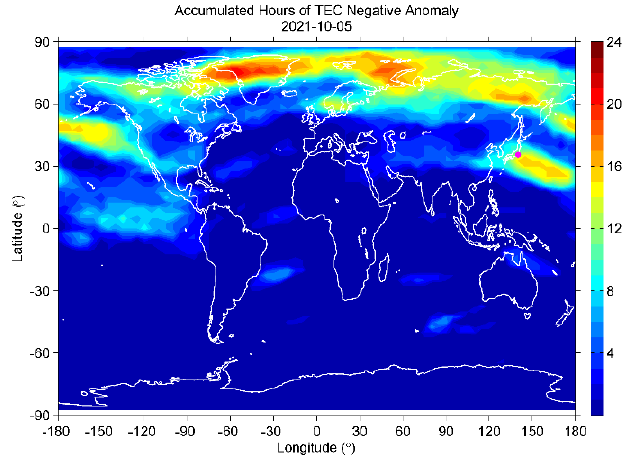
Figure 22. Same as in Figure 21, but for 5 October.